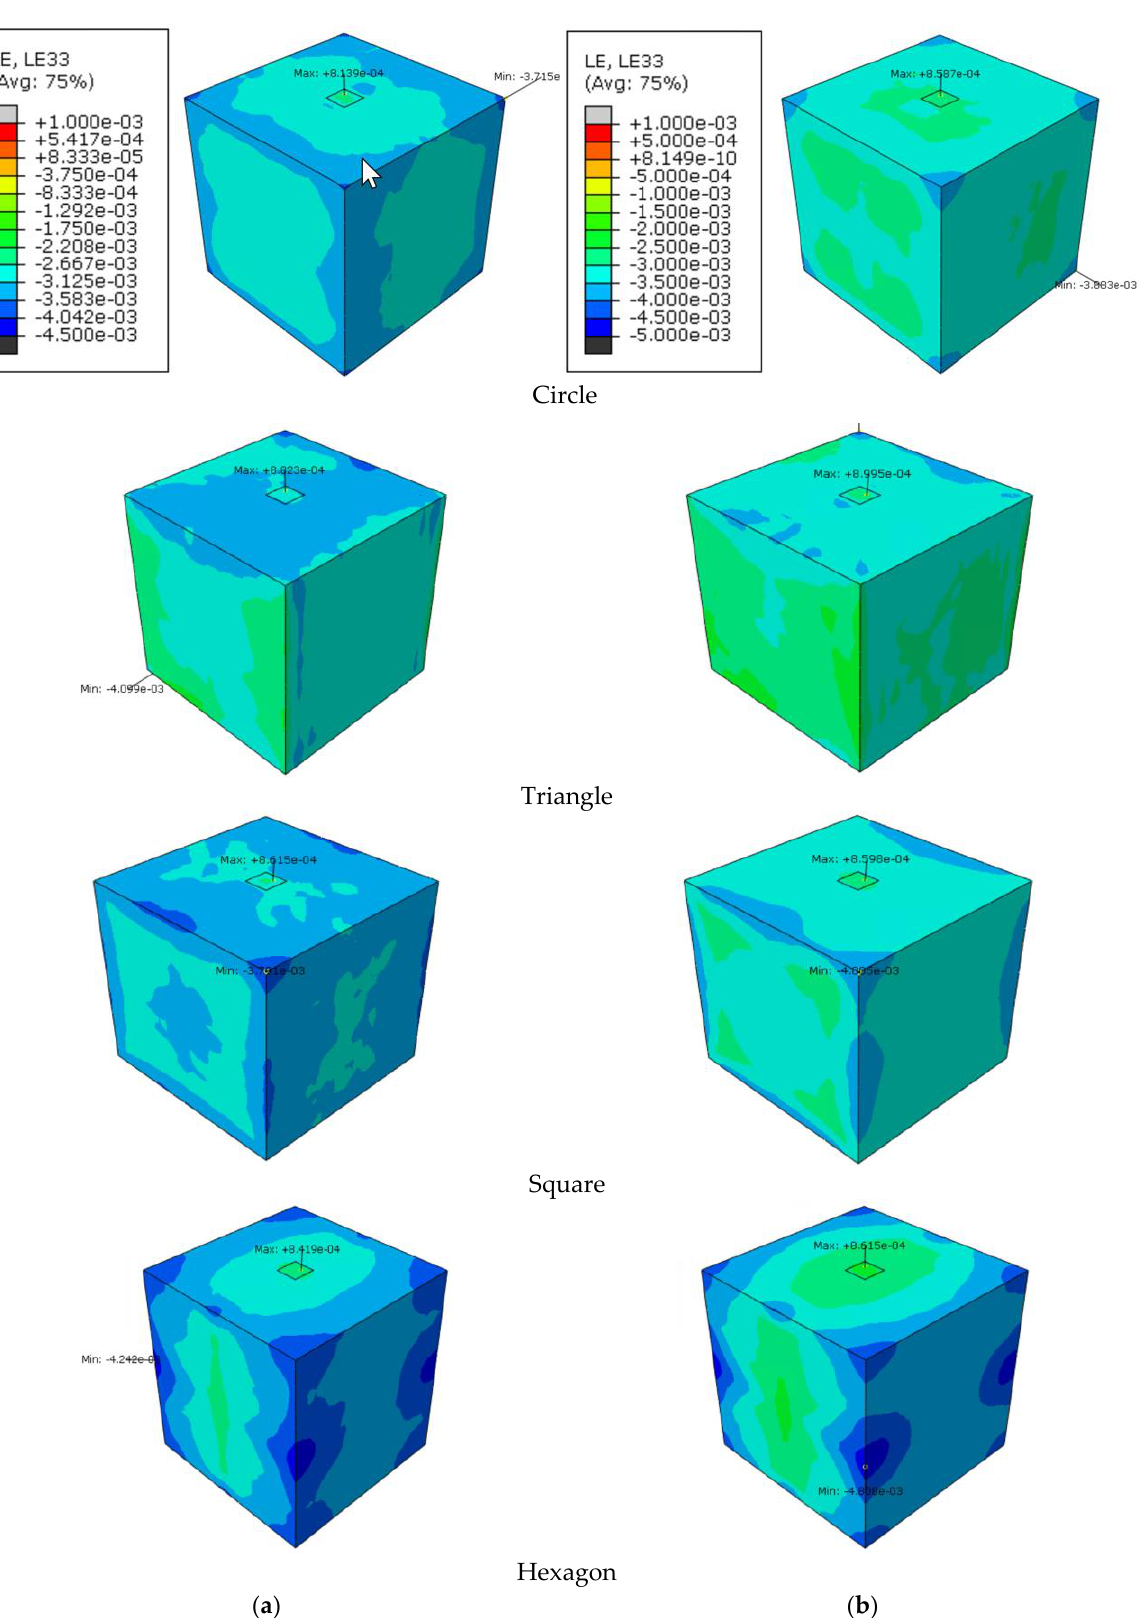
Figure 13. Pressure in the specimen at two increments of time. ( a ) t = 0.6 ms and ( b ) t = 0.7 ms